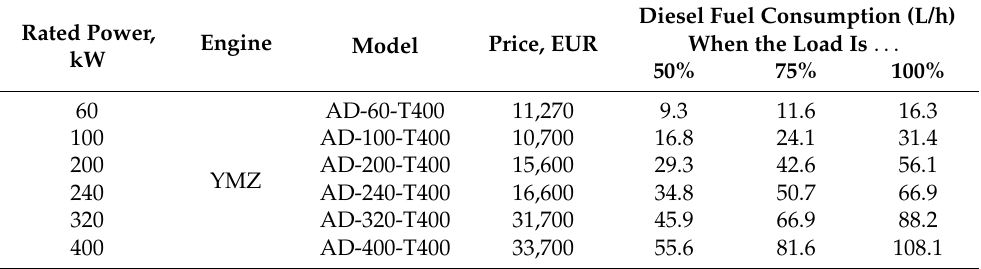
Table 4. The main DGs characteristics of YMZ.